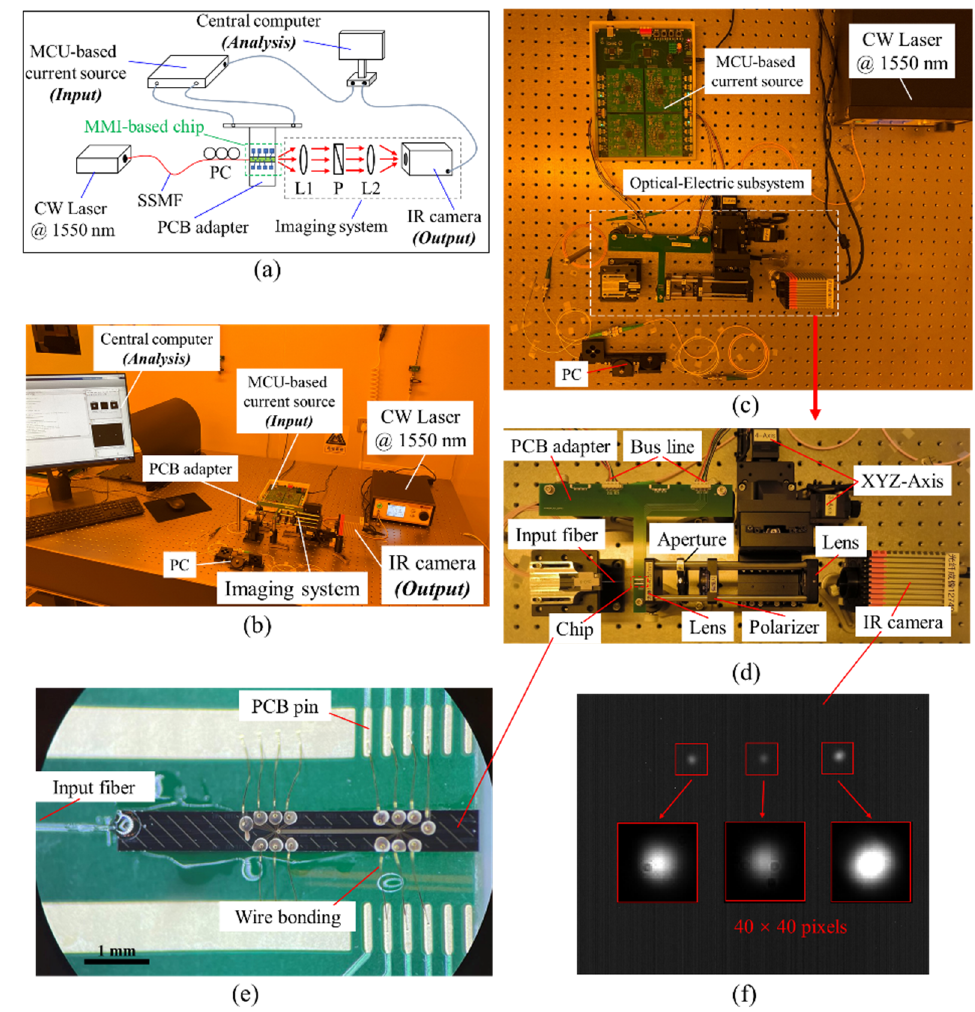
Figure 5. ( a ) The diagram and ( b – d ) the actual photos of the FPWE system. ( e ) The microscope photo of the optical chip on the adapter and with the input fiber. ( f ) Actual IR camera shot of the chip output facet. Inset shows the identified output spots within the 40 × 40 pixels (red squares). SSMF, standard single-mode fiber; PC, polarization controller; L1&L2, lens; P, polarizer.